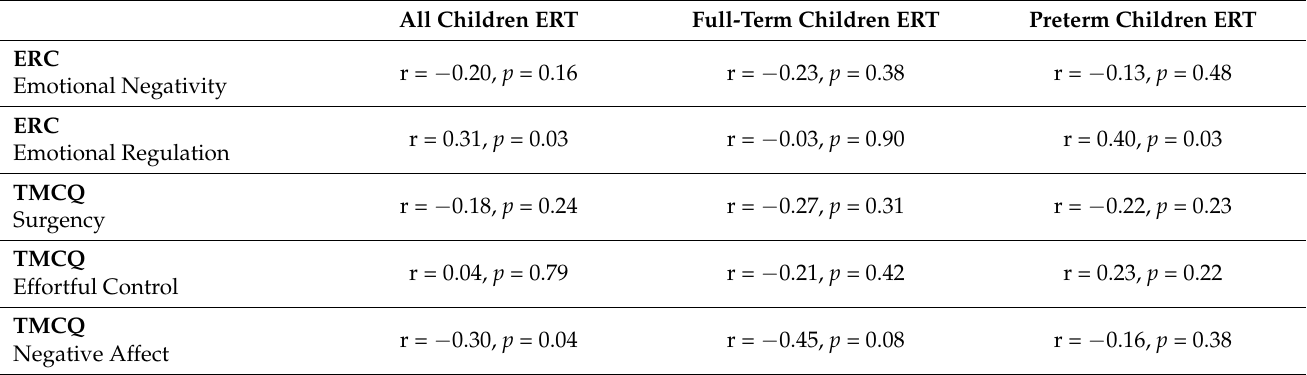
Figure 6. Correlations between ERT emotion recognition, ERC emotion regulation, and TMCQ negative affectivity. Table 8. Partial correlation between ERT and ERC and TMCQ, controlling for PSI-Parental Dis- tress.